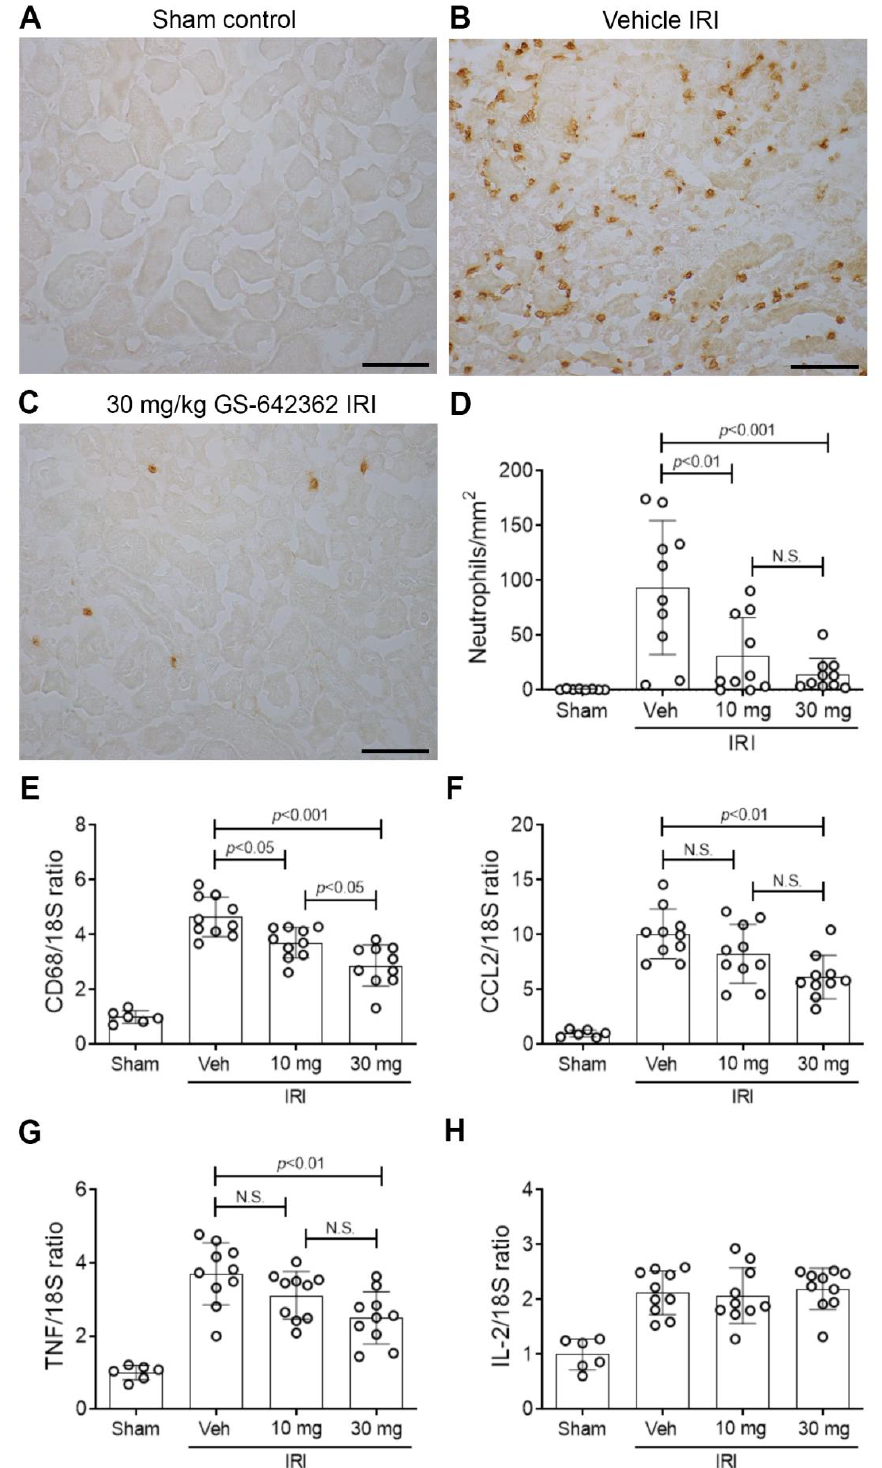
Figure 4. Neutrophil and macrophage infiltration in renal ischemia/reperfusion injury (IRI). Groups of mice (n = 10) were treated with vehicle, 10 or 30 mg/kg/BID GS-642462 and compared to sham controls (n = 6). ( A – C ) Immunostaining of Ly6G+ peroxidases. ( A ) Sham control lacks neutrophils. ( B ) Vehicle-treated IRI shows many infiltrating neutrophils in an area of tubular damage. ( C ) IRI treated with 30 mg/kg GS-642362 shows a dramatic reduction in neutrophil infiltration. Bar = 100 µ m. ( D ) Graph of Ly6G+ neutrophils. RT-PCR analysis of mRNA levels for ( E ) CD68, ( F ) CCL2, ( G ) TNF, and ( H ) IL-2. N.S., not